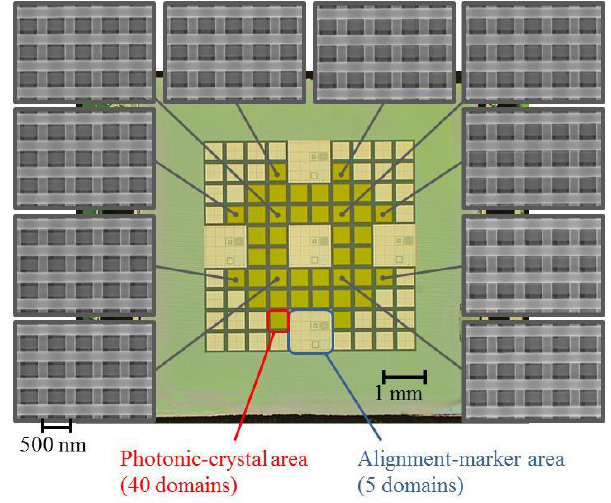
Figure 13. Optical microscope image of whole sample and SEM image of each 3D photonic crystal.